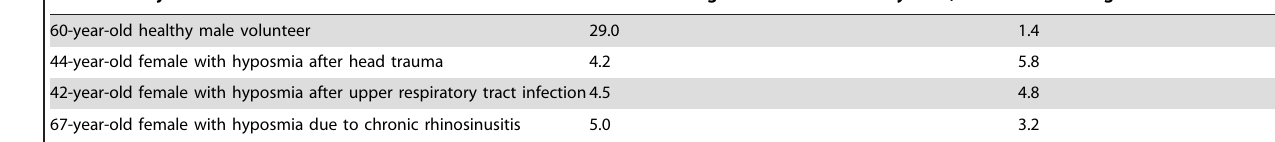
Table 2. Functional olfactory measurements in selected subjects.